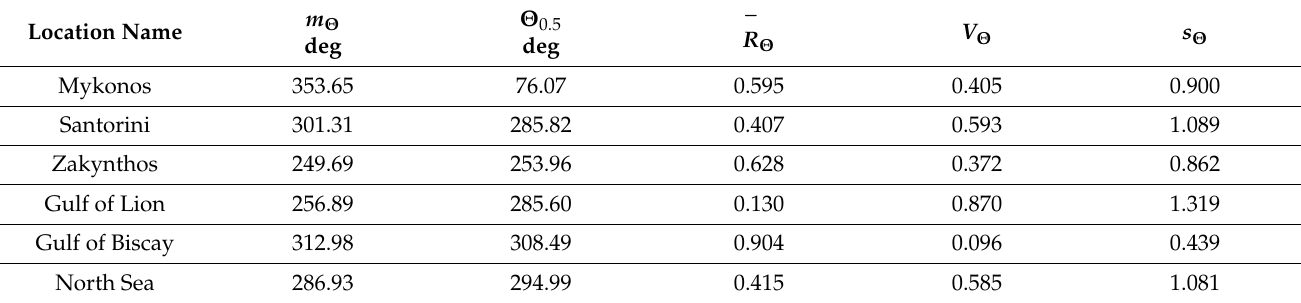
Table 3. Basic circular statistics of mean wave direction at the examined locations.